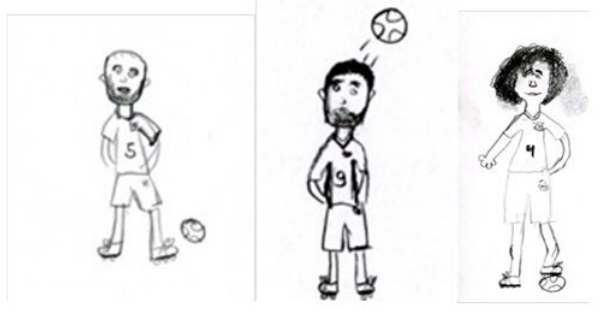
Figure 1. A Brazilian child's drawing of players from Iran, England and Brazil in their actual size.